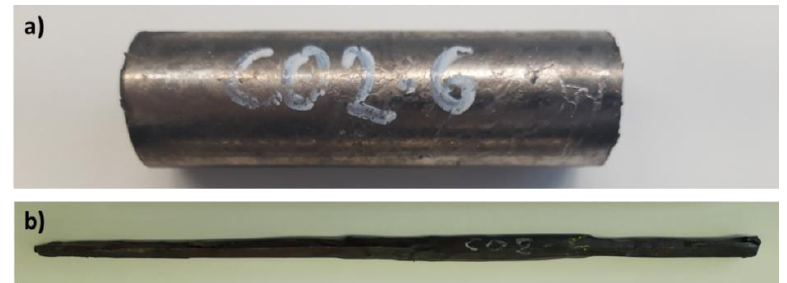
Figure 1. ( a ) Ingot cast in the levitation vacuum furnace and ( b ) bar forged from the ingot. alloy. The C content was analyzed by Infra-Red (IR) detection after a sample